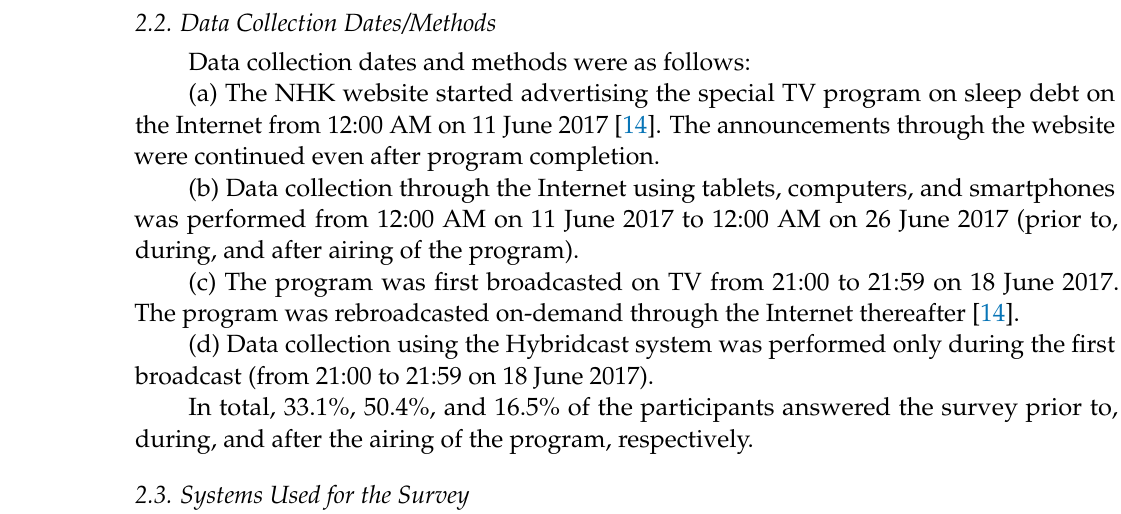
Figure 2. Television (TV) remote controller used in the Hybridcast TV system. Solid and dashed arrows indicate “d button” (data button) used to start the Hy- bridcast system and ‘enter’ button, respectively. Blue, red, yellow, and green colour but- tons (white circle) can be used to answer four-choice questions. 2.4. Questionnaires The participants were enquired about their sex (male or female), age (<20, 20 – 39, 40 – 64, ≥ 65 years) and usual sleep duration in 30-min intervals, and the Athens Insomnia Scale (AIS) questionnaire was administered. In Japan, those aged < 20 year and ≥ 20 years are considered minors and adults, respectively. Those between the ages of 40 and 64 years are considered middle-aged, and those over 65 years old are considered elderly. We thought that four-choice questions were easier to answer than pull-down questions and would encourage active participation. Thus, we chose to use a four-choice question with re- sponses corresponding to age ranges of <20, 20 – 39, 40 – 64, and ≥ 65 years in this survey.